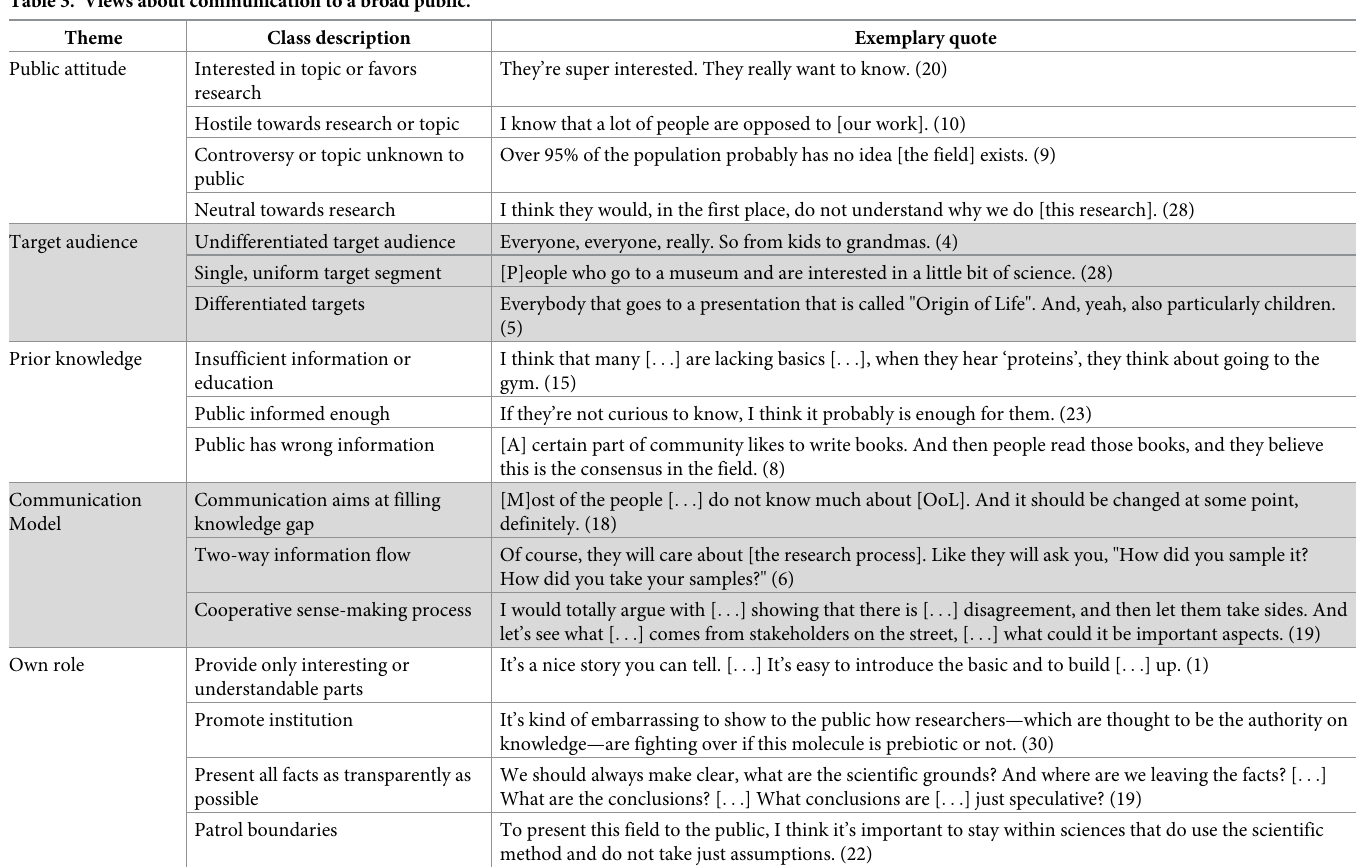
Table 3. Views about communication to a broad